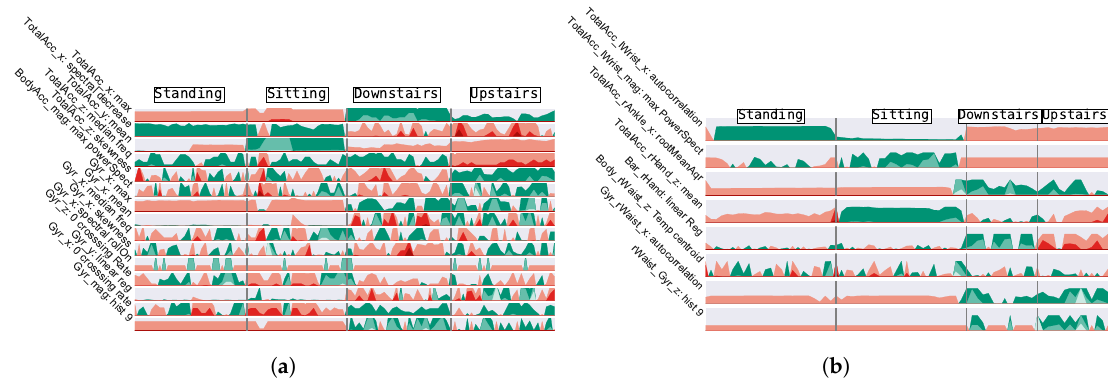
Figure 6. Horizon Plot showing the features and their behaviour along some of the dataset activities. In the y axis, it is presented the information about the sensor, its signal axis and the feature name. The green and red colours denote the signal’s positive and negative values, respectively, with its intensity increasing with the feature’s normalised absolute value and decreasing otherwise. ( a ) UCI dataset. ( b ) CADL dataset. Table 2. SL and Unsupervised Learning (UL) methods classification’s performance shown in accuracy and Adjusted Rand Index (ARI) score, respectively. For all listed values it is shown its 10-fold Cross-Validation (CV) average and standard deviation in percentage, the latter between parenthesis. The highest performance is shown in bold for each